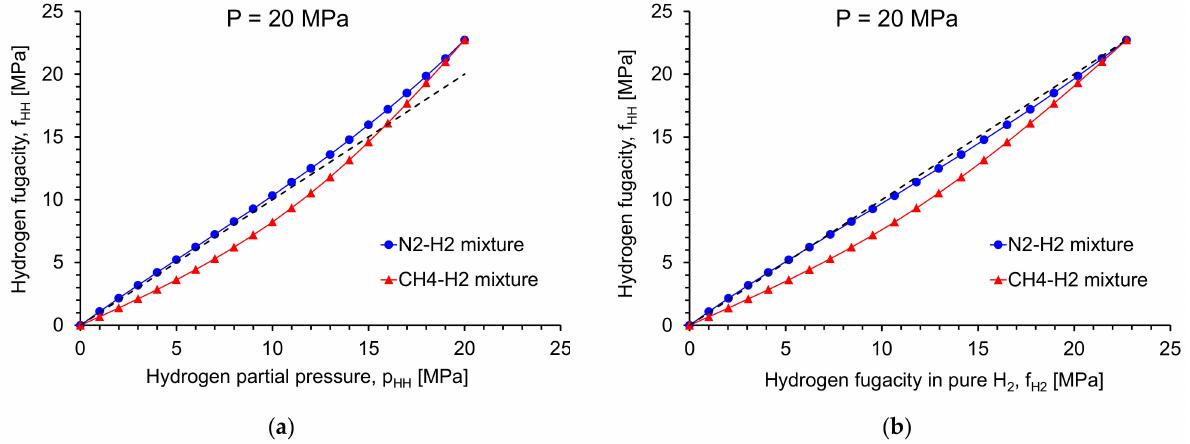
Figure 4. Evolution of f HH in N 2 -H 2 and CH 4 -H 2 gas mixtures at a total pressure of 20 MPa as a function of ( a ) p HH and ( b ) fugacity of hydrogen in pure H 2 gas, f H2 . The dashed line represents the one-by-one